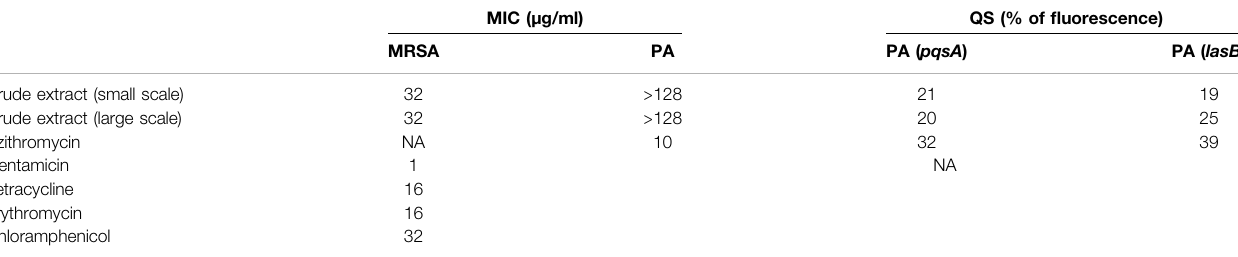
TABLE 1 | Minimum inhibitory concentration (MIC) and quorum sensing inhibition (QS) assays of crude extract compared to several antibiotics. MIC